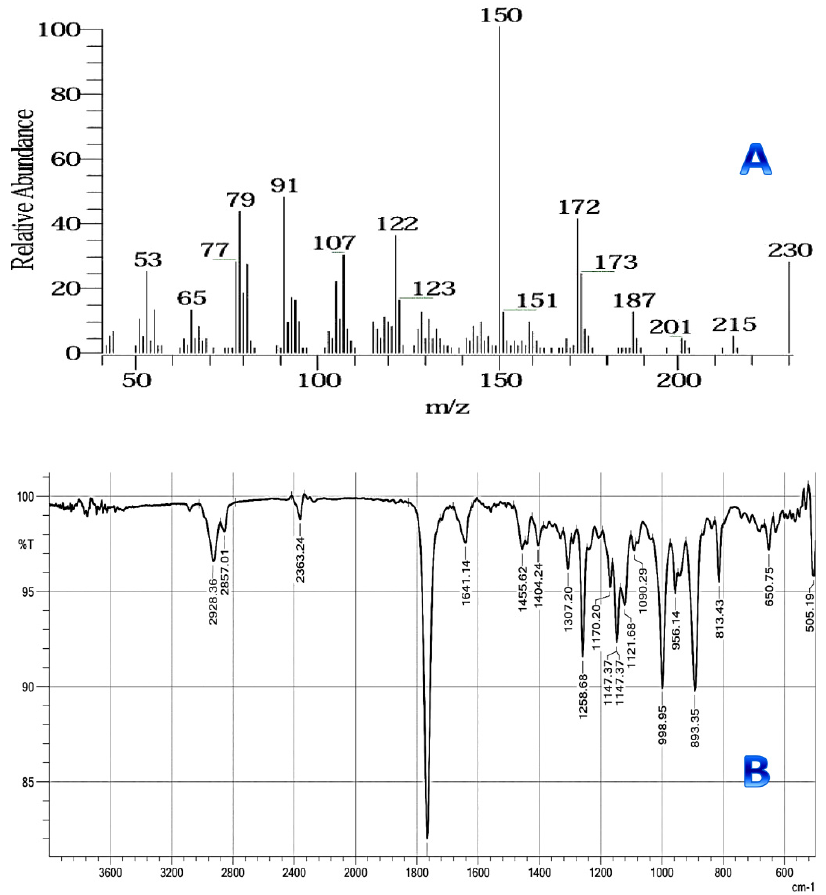
Figure 4. Mass spectrum ( A ) and Infrared spectrum ( B ) of the isolated anticandidal compound “dehydrocostus lactone” from the n -hexane roots extract of Saussurea costus .